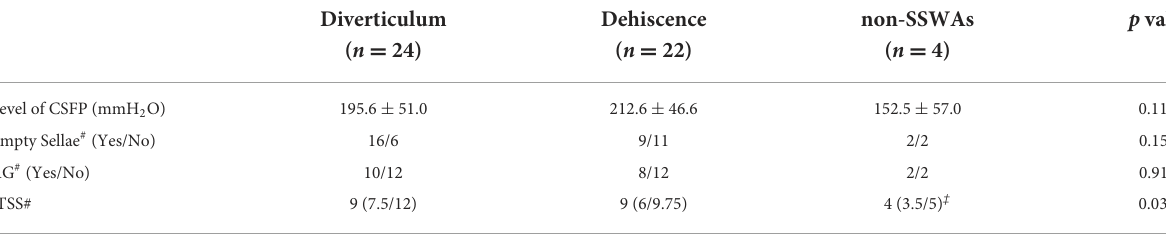
‡ Statisticaldifferencefoundbetweensigmoidsinuswallanomalies(SSWAs)vs.non-SSWAsgroups,Mann-Whitneytest, p = 0.014. # Empty Sellae, arachnoid granulation (AG) and index of transverse sinus stenosis (ITSS) were measured on 46 participants (Diverticulum: Dehiscence: non-SSWAs = 22:20:4) using magneticresonancevenogram. Variablesareexpressedasmean ±